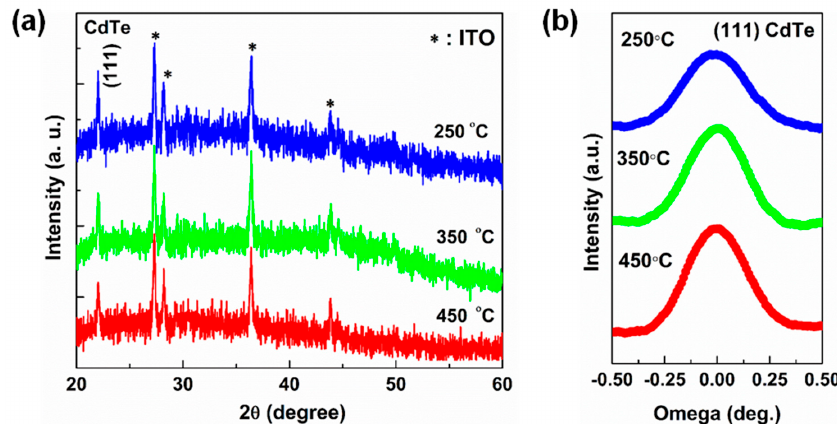
Figure 3. ( a ) XRD patterns of CdTe films grown under different substrate temperatures; ( b ) A rocking curve measurement for the 2 θ = 23 ◦ diffraction peak.